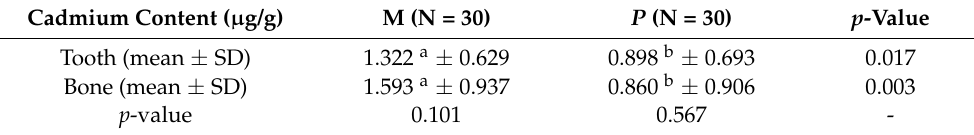
Table 3. Cadmium content in tested samples taken from patients differing in place of residence.